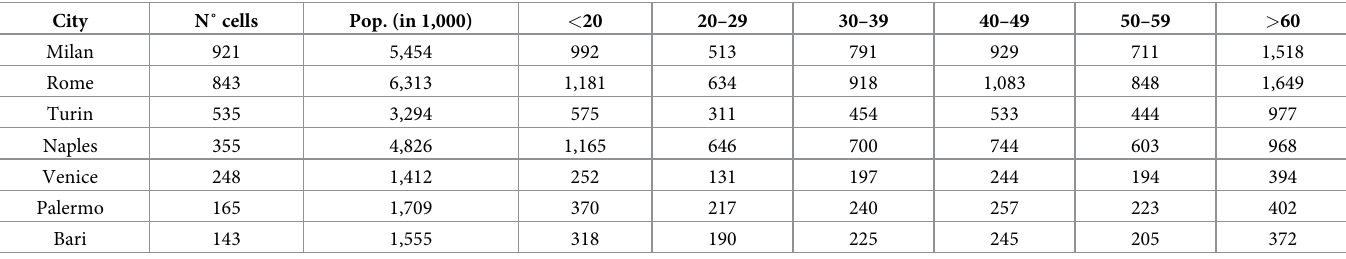
Table 1. Metropolitan cities. Our analysis focuses on seven metropolitan cities across Italy. Here, we report the number of spatial cells of the mobile phone network and the population (in thousands) of each of these cities split across 6 age groups. Population data is retrieved from the 2011 Italian census and comprises all the census sections within the phone cells considered for each city. It is important to highlight that in each cell of the network there can be several mobile phone users, thus we cannot estimate the fraction of the census population included in our data set. Note that the age groups provided by the Italian census do not perfectly match those of the Telecom Italia